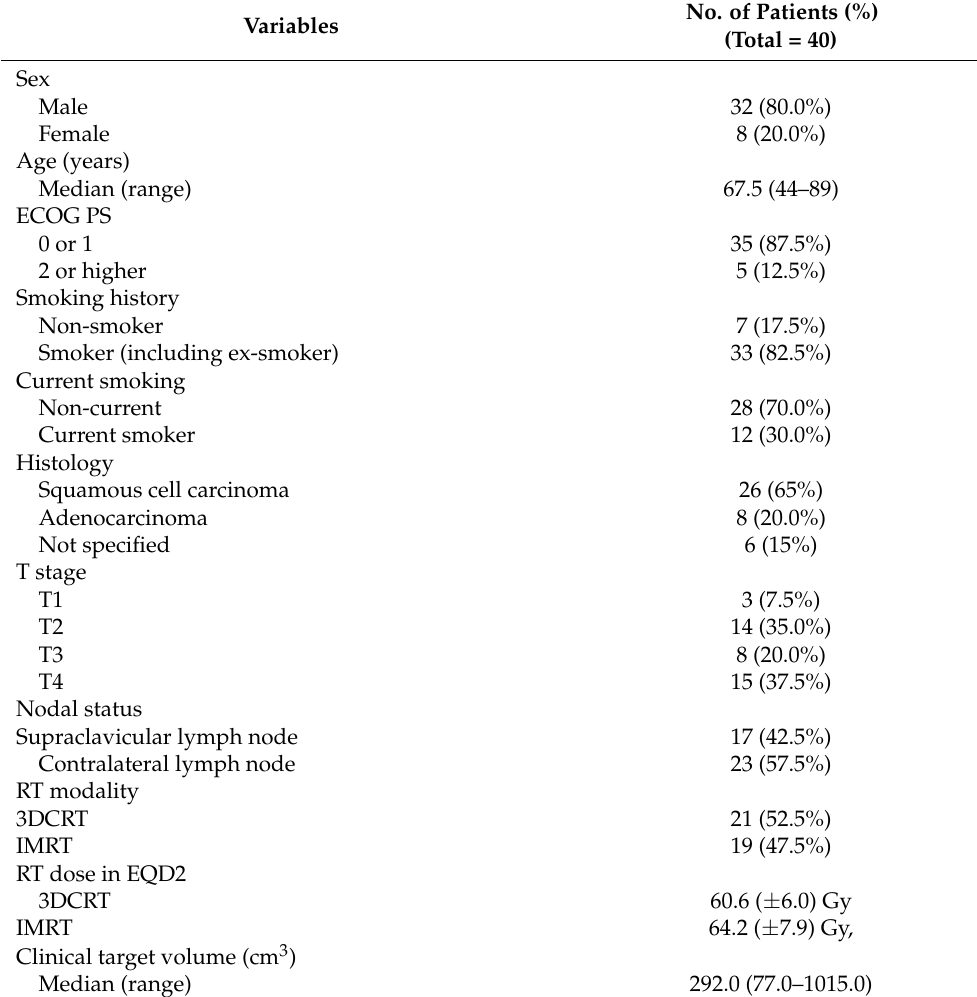
Table 1. Patient characteristics.